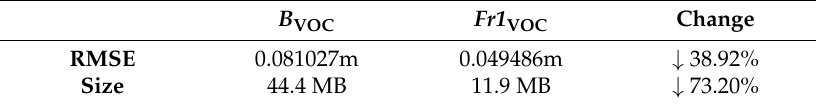
Table 3. Comparison of trajectory error and